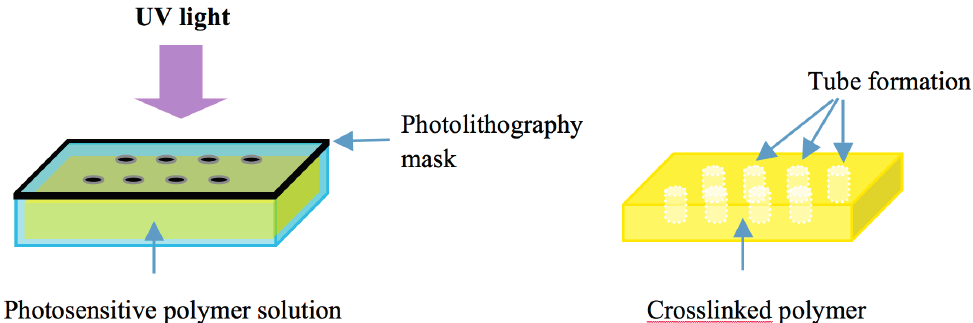
Figure 4. Photopatterning approach for fabrication of microfluidic constructs. A thin film of a photosensitive polymer is exposed to UV light through a predesigned mask. There